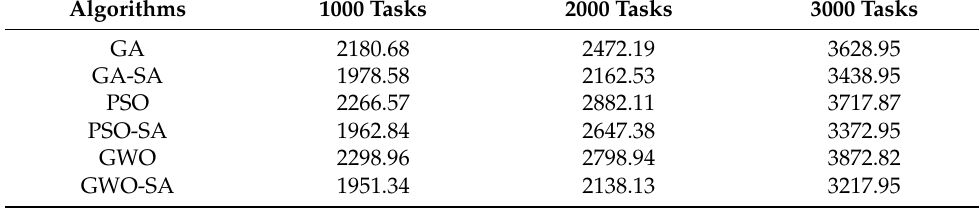
Table 7. Makespan.